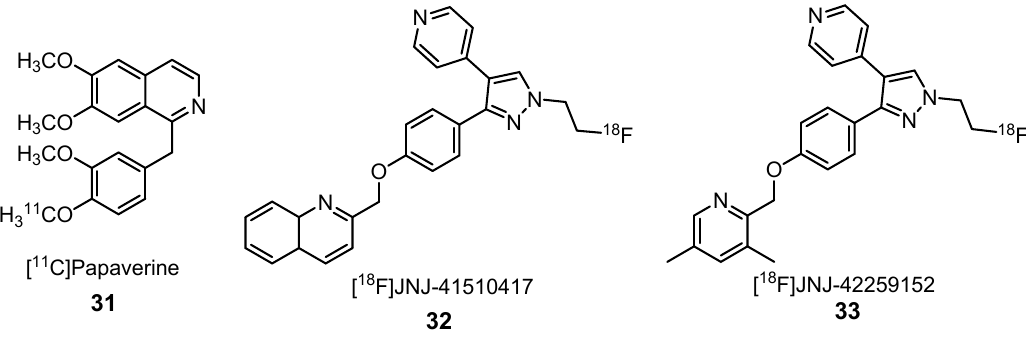
Figure 13. Radiotracers 31 – 33 for phosphodiester-10A (PDE10A) visualization in the brain by PET imaging [57–62].